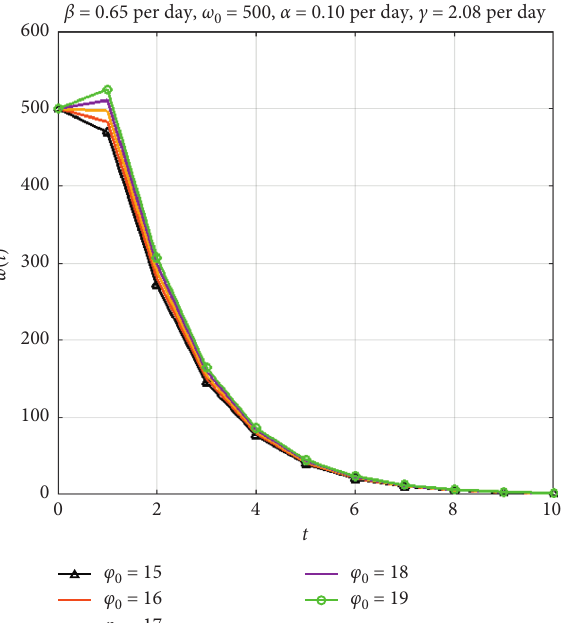
Figure 5: The number of infected cells ω for different values of time t and initial concentration of viral particles in plasma φ � 500 , α � 0 . 10 day − 1 , and c � 2 . 08 day − 1 β � 0 . 65 day − 1 , ω 0